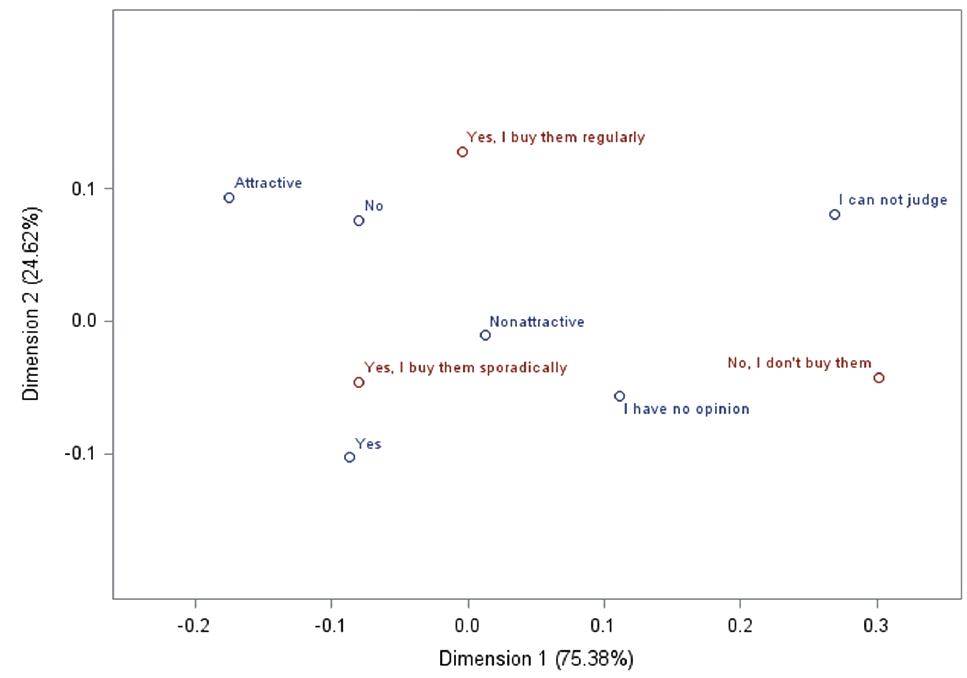
Figure 1. Correspondence